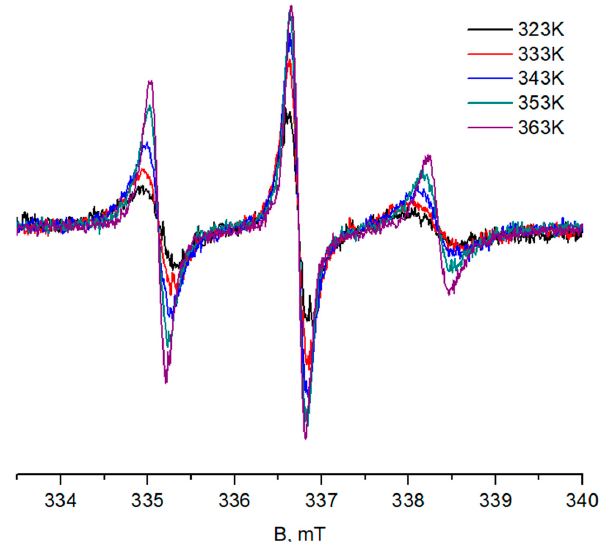
Figure 3. Spectra of TEMPO in globules in copolymer V solution (5 wt%, PBS) recorded in the presence of Cu 2+ ions at 323–363 K. The EPR spectra of TEMPO in 5 and 10 wt% P(NIPAM- g- PLA) solutions in the presence of Cu 2+ ions (type B species) at different temperatures were simulated within the